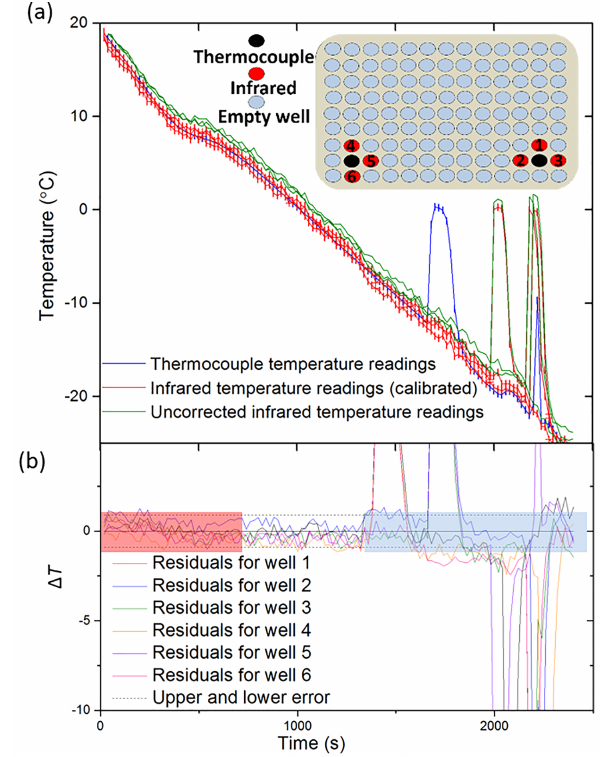
Figure 4. Tests of the IR temperature measurements using thermo- couples positioned in a polyethylene multiwall plate. (a) The tem- perature measurement from a thermocouple placed within a well vs. three IR measurements of surrounding wells corrected using the calibration described in Sect. 2.2. The uncorrected IR data can be seen in green, with the corrected IR data in red and the thermocou- ple readings in blue. A diagram of the wells within a 96-well plate chosen for the comparison of IR and thermocouple measurements is displayed as an inset. The numbers of the wells correspond to the residuals in (b) . Red wells represent the wells measured with the infrared camera, and black wells represent those measured with thermocouples. It should be noted that one of the four surround- ing IR well temperature readings was discarded from each experi- ment as the thermocouple wire impeded the temperature measure- ment. Note that the freezing events at ∼ 2000s appear to cause some heating in the adjacent well. (b) Plot of the difference in tempera- ture between the thermocouple readings for two wells and six cor- responding wells measured with the IR camera as in Fig. 3. The estimated error in temperature for the IR camera is indicated with dashed lines ( ± 0 . 9 ◦ C). The range of freezing is highlighted in blue as this is where the thermal properties of ice and the initiation of heat release will affect the temperature readings. Highlighted in red is the section of data before the well had equilibrated, and so the IR camera was likely reading a warmer surface temperature than the